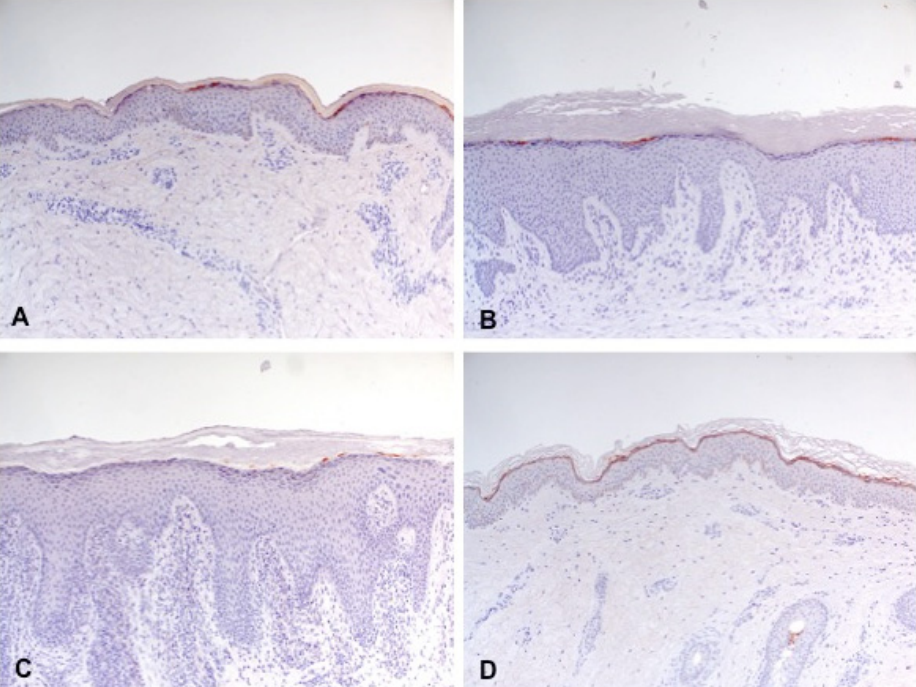
Figure 4. Reduced expression of filaggrin (partially interrupted brown staining line) in lesional skin of classic atopic dermatitis ( A ), atopic prurigo ( B ), and non-atopic prurigo nodularis ( C ) compared with healthy controls ( D ) shown by immunohistochemistry (100-fold magnification).